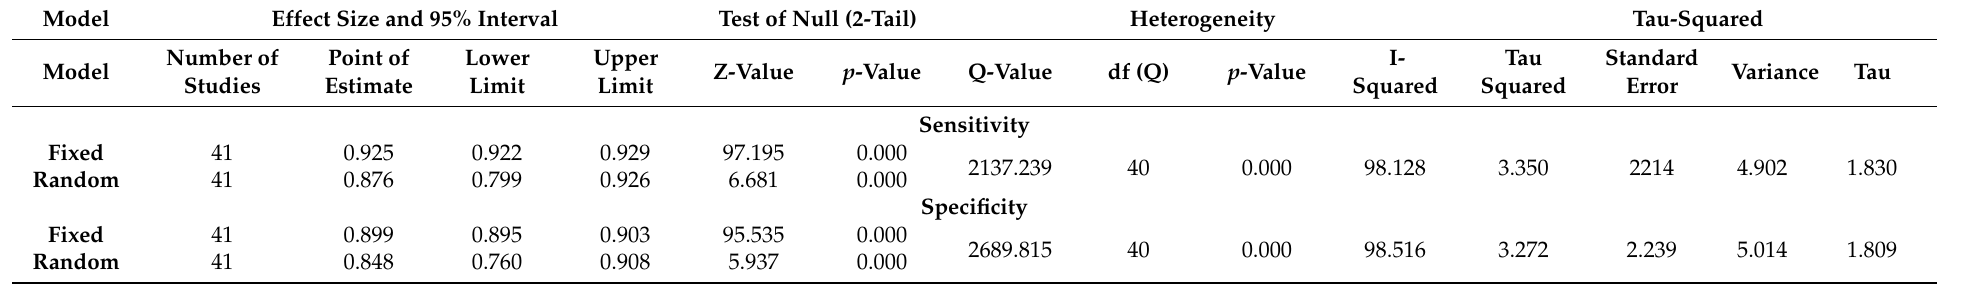
Table 2. Effect analysis of included